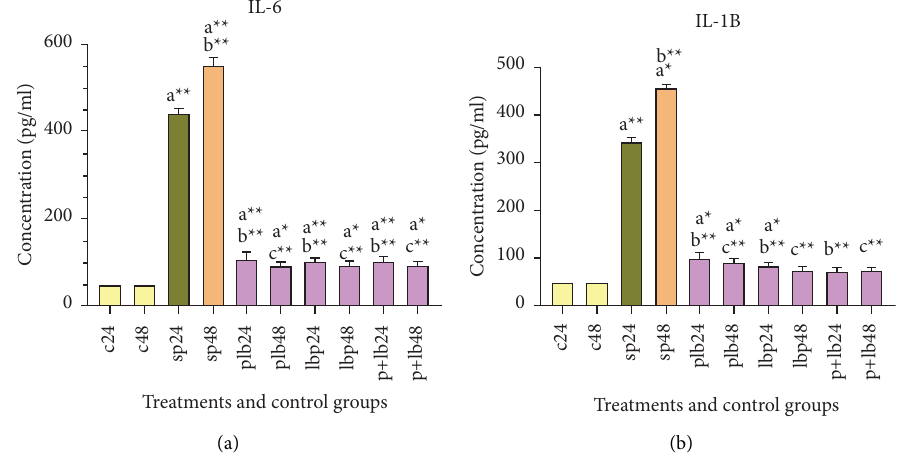
Figure 4: Diferent levels of concentrations of (a) IL-6 and (b) IL-1 β . Data were represented as mean SD. Te number 24 and 48 refers to diferent time orders of HT-29 cell line treatments. (C) represents control; (P) represents pathogen; PLB represents frst pathogen and then Lactobacillus/Bifdobacterium ; LBP represents frst Lactobacillus/Bifdobacterium and then sonicated pathogen; P+ LB represents sonicated pathogen and then Lactobacillus/Bifdobacterium were added simultaneously. Data were considered statistically signifcant when p < 0 . 05 ( ∗ p < 0 . 05, ∗∗ p < 0 . 001). Letter (a) indicates the relatedness between C24 and C48 with other treatments, letter (b) shows the relatedness between sp24 and other treatments, and letter (c) shows the relatedness between sp48 with other treatments. Te relatedness between other treatments is shown with